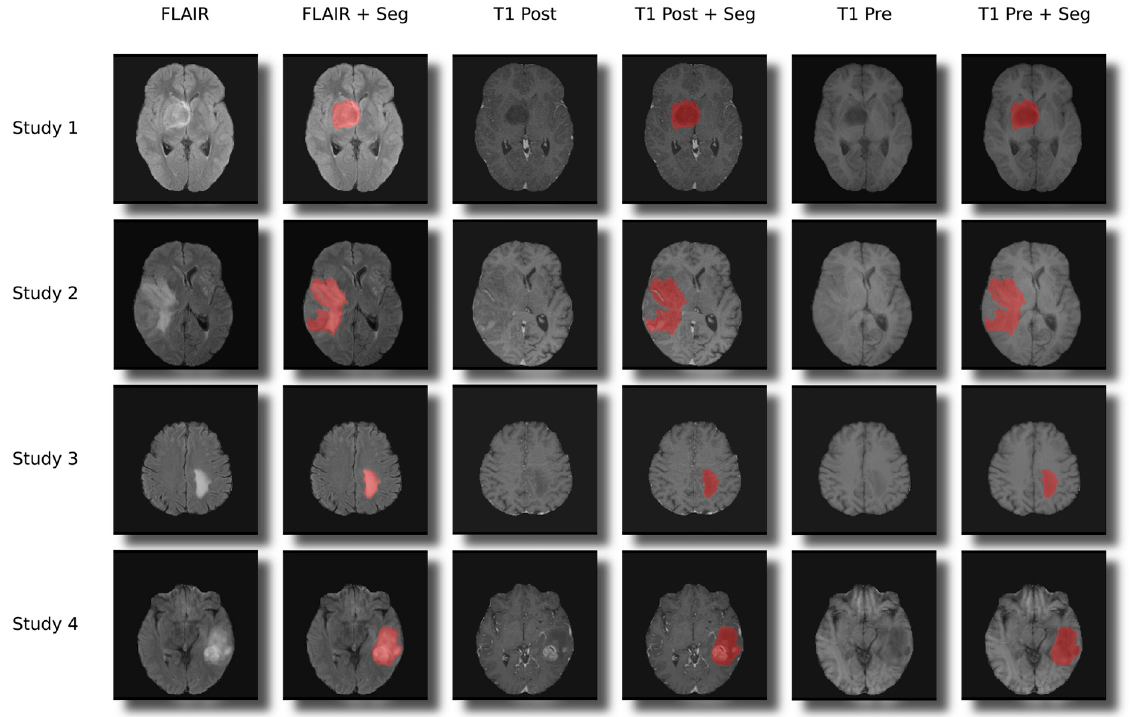
Figure 1. Examples for the segmentations and co-registration with other sequences.